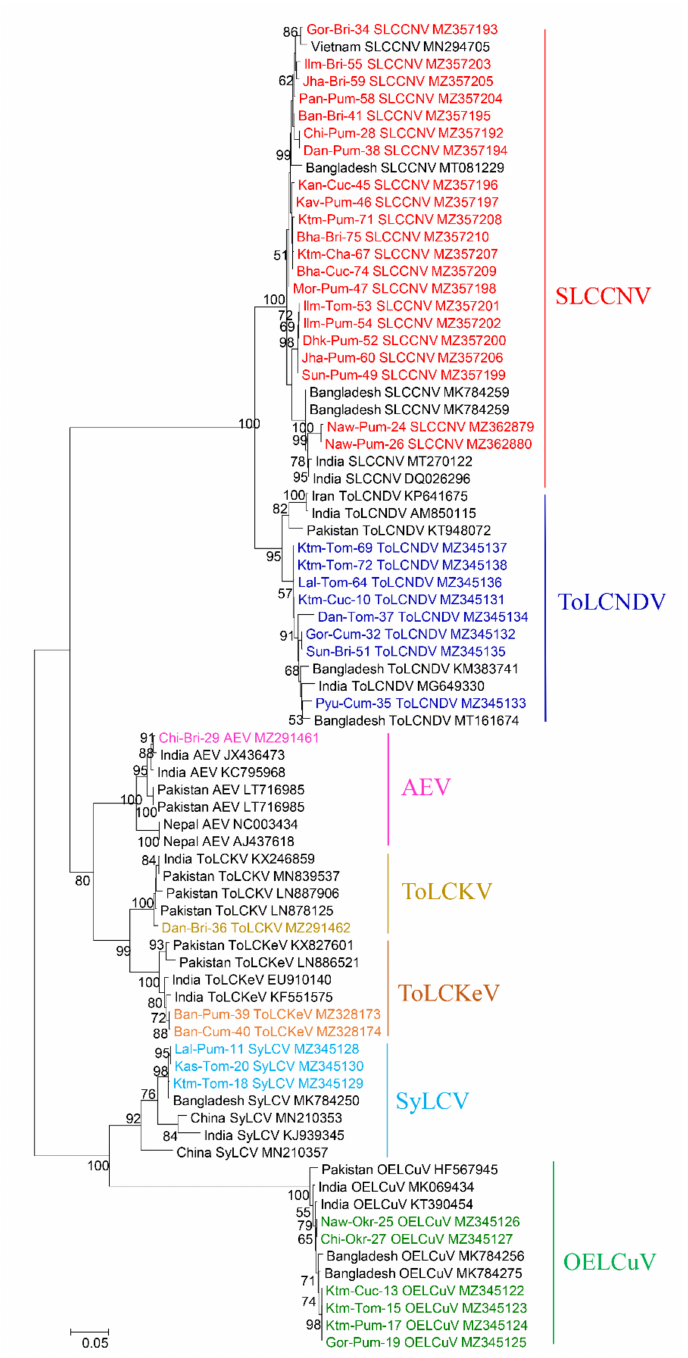
Figure 2. Maximum likelihood phylogenetic tree of begomoviruses sequences detected from three different cryptic species of Bemisia tabaci in Nepal. Different colors indicate begomovirus sequences from our samples (42 sequences), and black color indicates reference sequences obtained from the GenBank database (35 sequences). The phylogenetic tree was built in Mega6 using the HKY+G model. Among them, the detection rate of begomoviruses was highest for SLCCNV (27.63%; 21/76) followed by ToLCNDV (10.53%; 8/76), OELCuV (7.89%; 6/76), SyLCV (3.95%; 3/76), and ToLCKeV (2.63%; 2/76). Both AEV and ToLCKV were detected equally at the lowest rate of 1.32% (1/76) (Figure 3). The total detection rate of the begomoviruses in B. tabaci was 55.26% (42/76) (Figure 3). The virus detection rate was similar in three cryptic species such as Asia I (60%; 6/10), Asia II 1 (58.82%; 10/17), and Asia II 5 (53.06%;